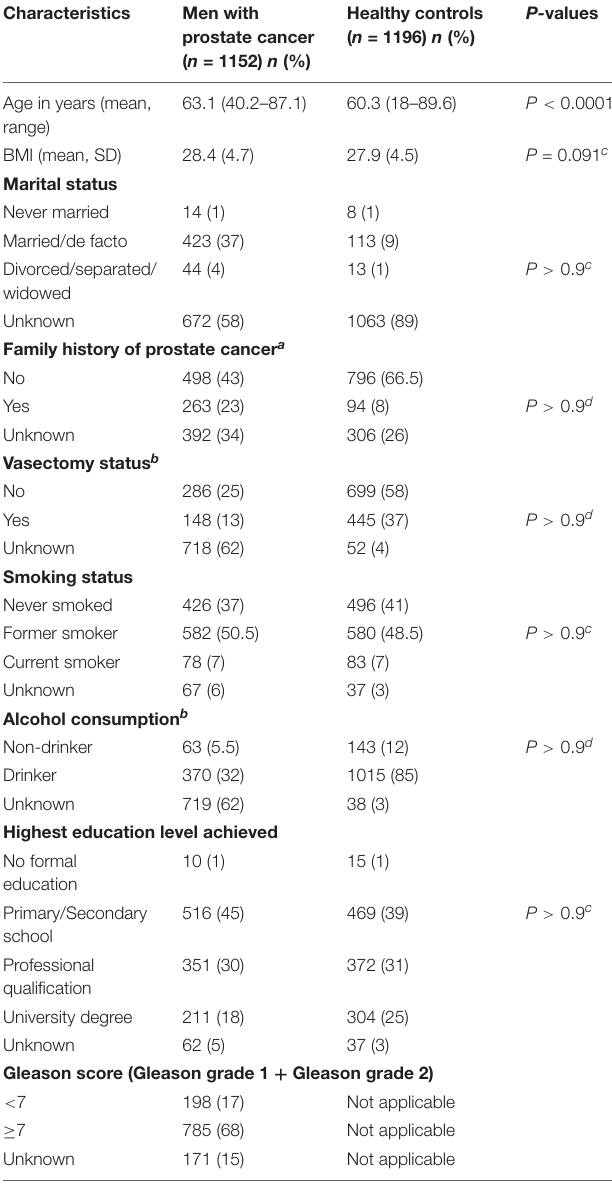
TABLE 1 | Socio-demographic and clinical characteristics of the Queensland study populations. Characteristics